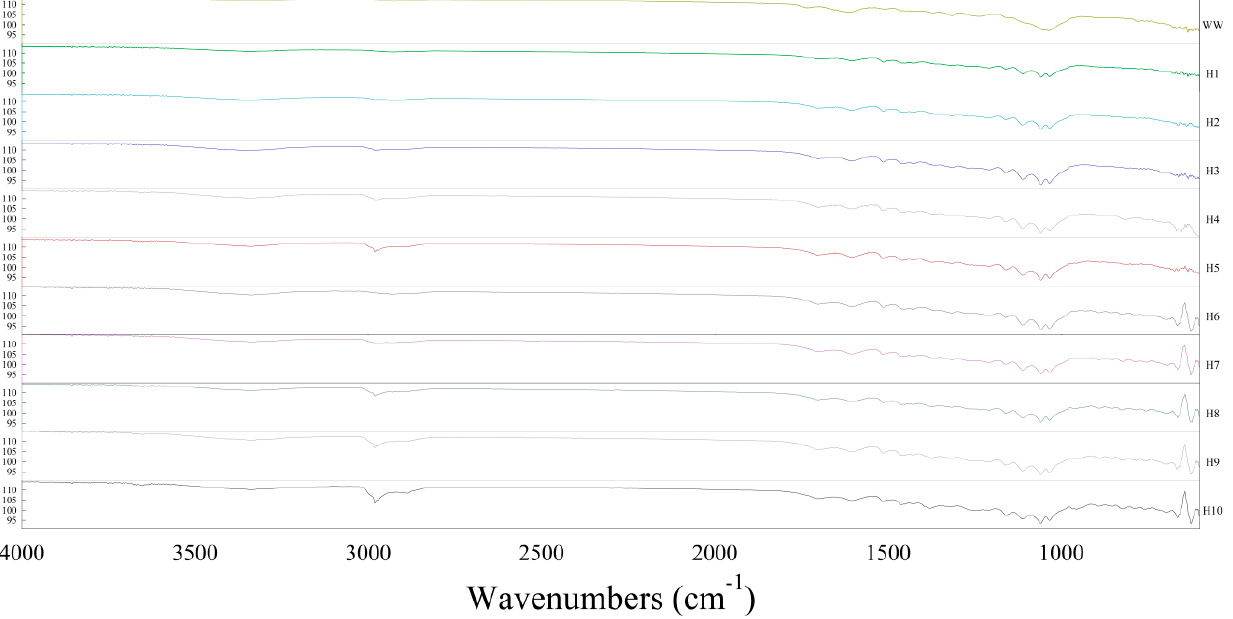
Figure 3. FT-IR result of biomass and hydrochar.